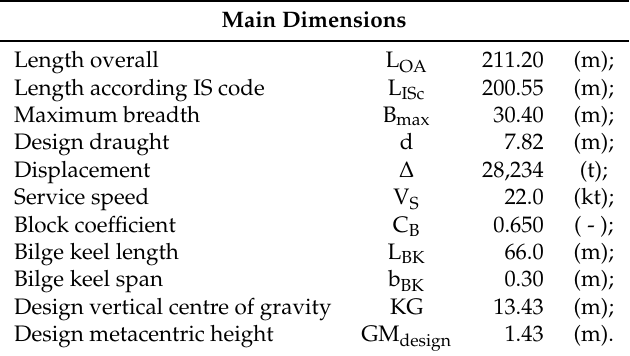
Table 2. Ro-Ro pax ferry main dimensions.